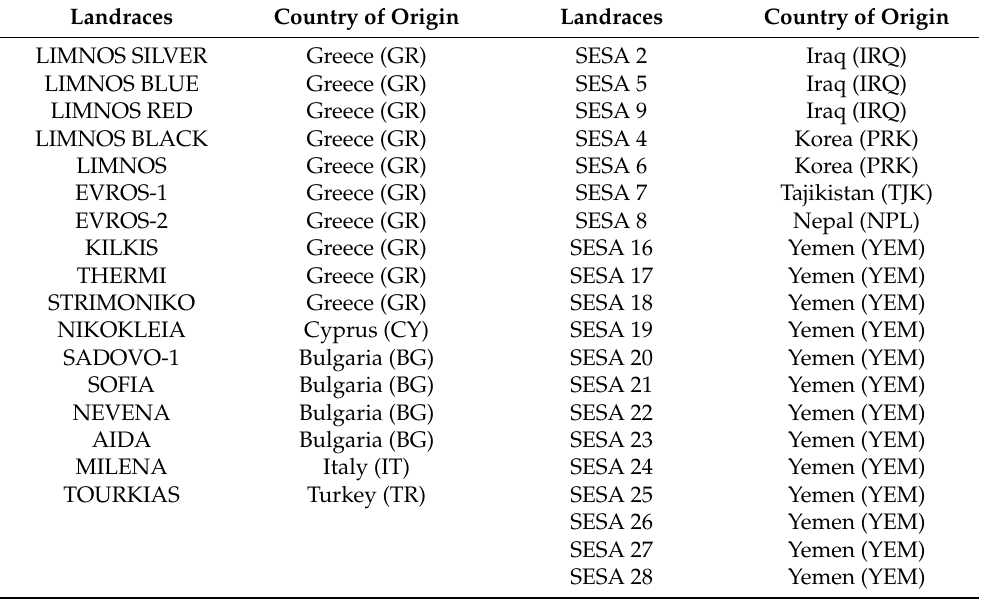
Table 4. The 37 sesame landraces used in this work and their geographic origin. Landraces Country of Origin Landraces Country of